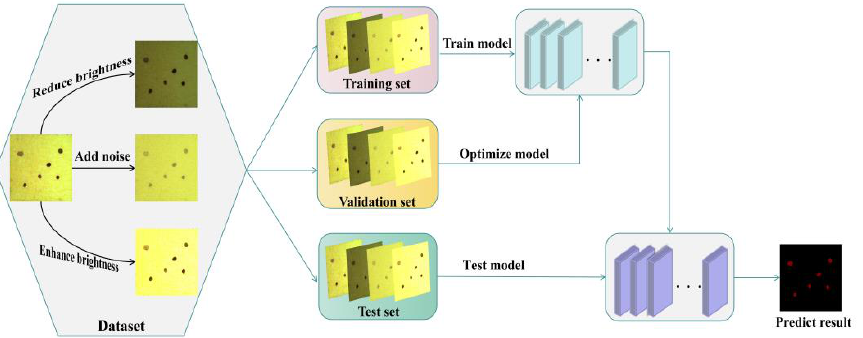
Figure 8. Flow chart of dataset expansion and model prediction.